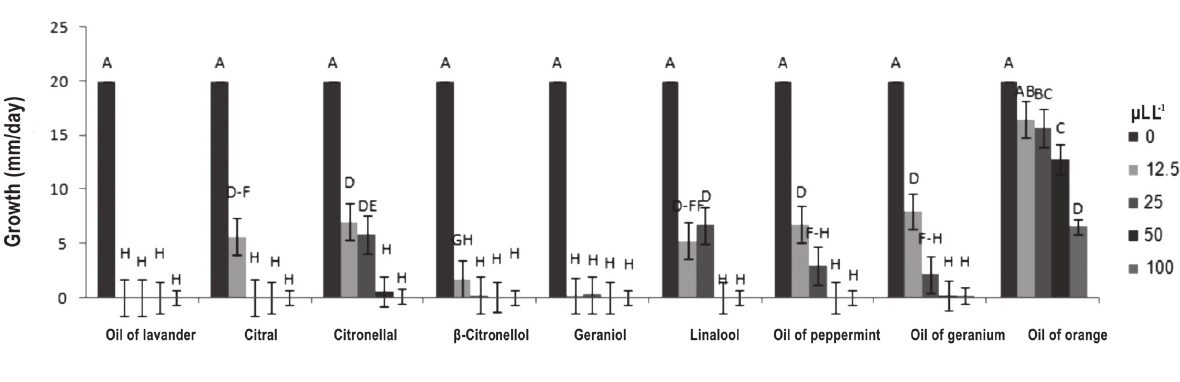
Figure 3. Mean colony growth rate (mm day -1 ) (fumigant effect) of Botrytis cinerea on agar plate amended with differ- ent essential oils Bars followed by the same letter are not signi fi cantly different ( P ≤ 0.01), Duncan’s Multiple Range Test. (Concentration of oil of lavender: 0, 0.25, 0.5, 1, 2 mL L -1